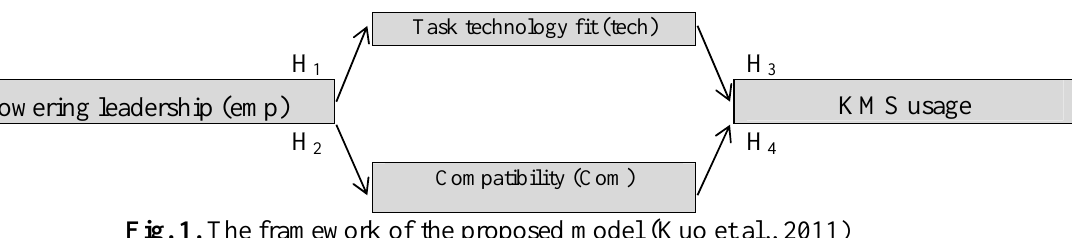
Fig. 1. The framework of the proposed model (Kuo et al., 2011